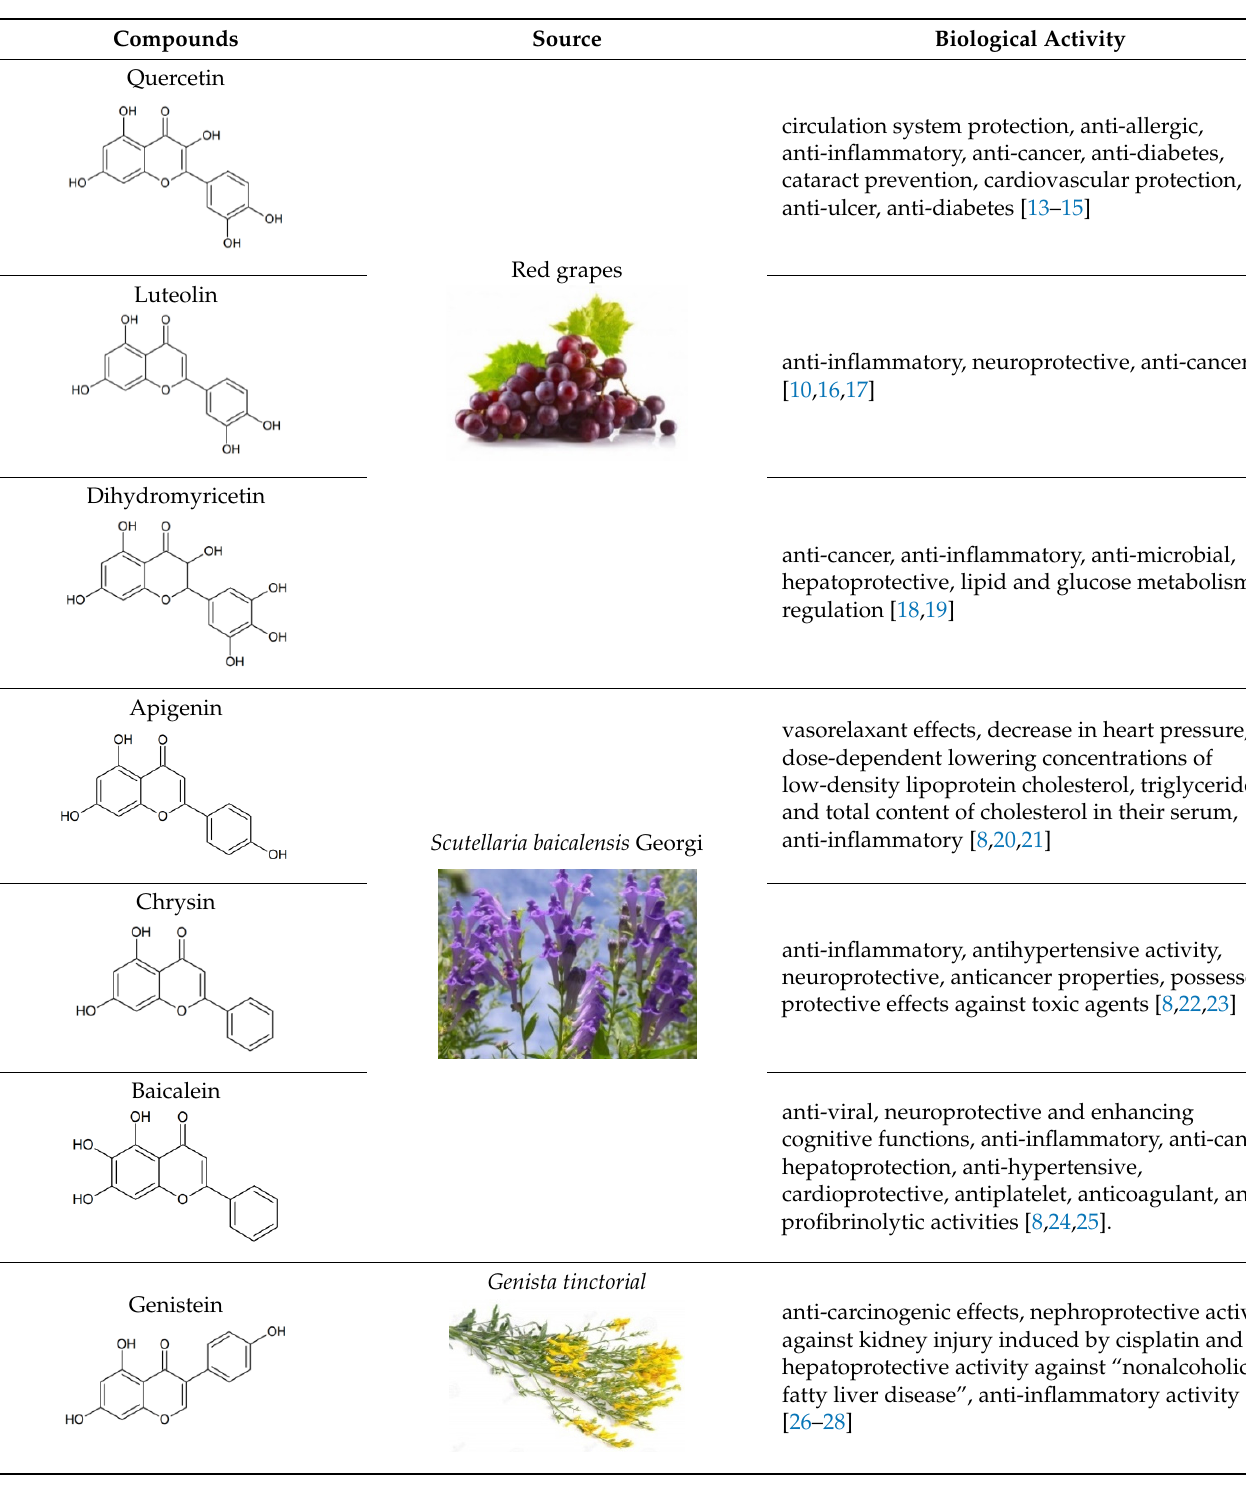
Table 1. Sources and directions of the biological activity of some derivatives of flavonoids and coumarins.